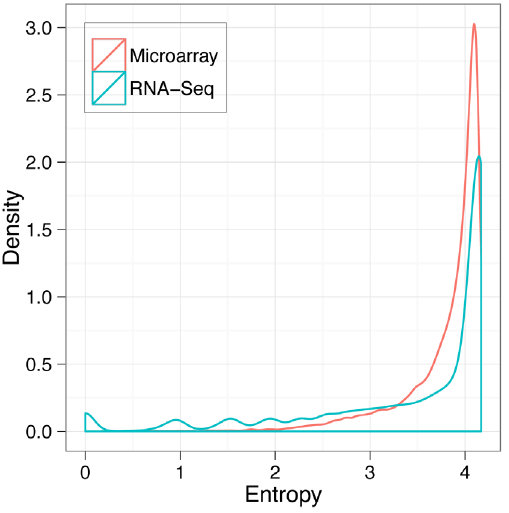
Figure 3. Shannon entropy was calculated for each gene expression profile to assess their tissue specificity. Distribution of the entropy values is shown for both Microarray and RNA-Seq datasets. Tissue-specific expression patterns are more prevalent in the RNA-Seq dataset (Mann-Whitney U test, p , 0.01) indicating higher sensitivity of the platform to the expression differences between